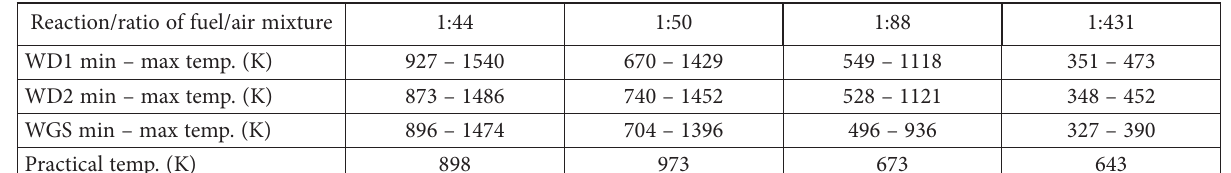
Table 4. Calculated and measured EGT using different reactions and mixtures Reaction/ratio of fuel/air mixture